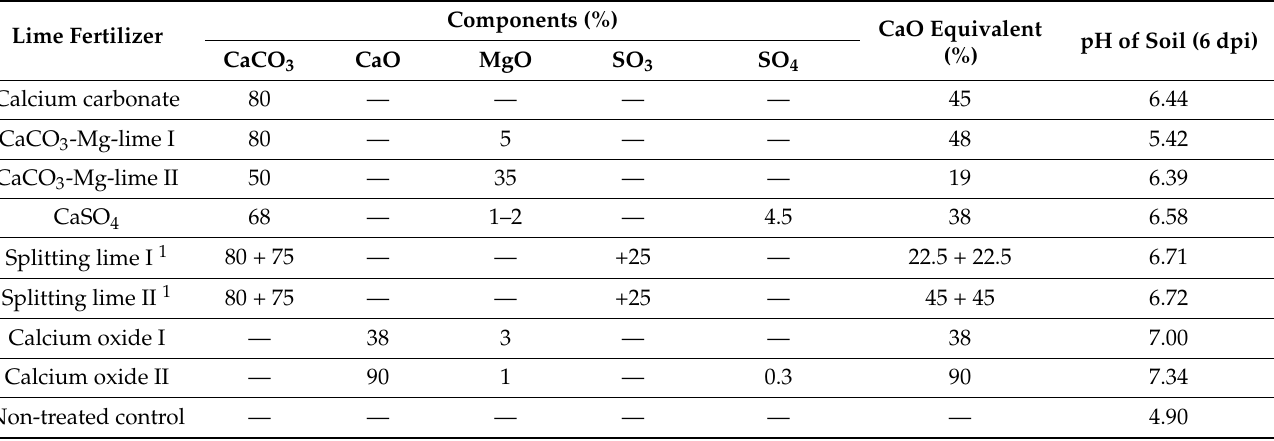
Table 1. Characteristics of the lime fertilizers